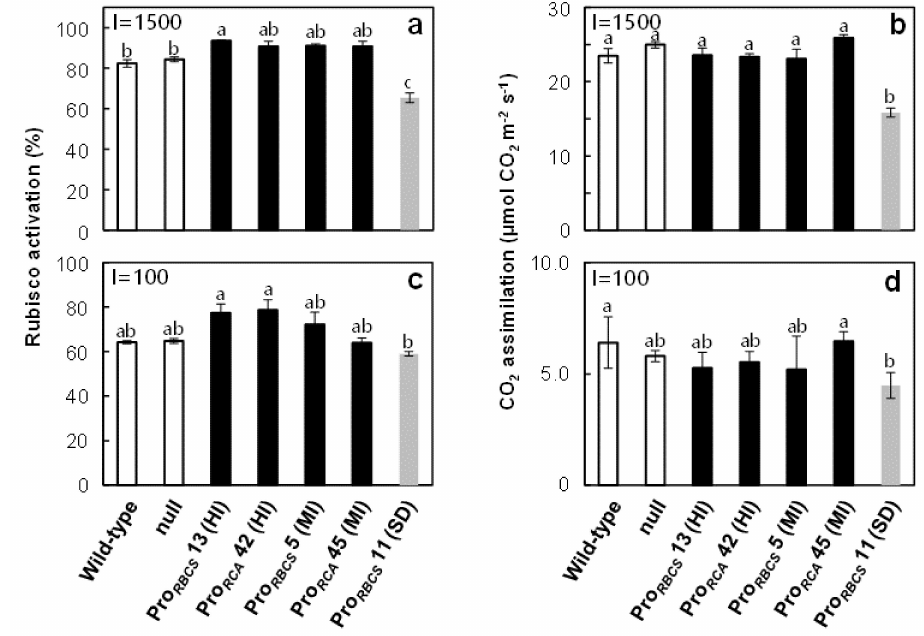
Figure 5. ( a,c ) Rubisco activation and ( b,d ) the rates of CO 2 assimilation at an ambient CO 2 partial pressure (Ca = 40 Pa) and high and low irradiances (PPFD of 1500 and 100 µ mol quanta m –2 s –1 ). Measurement were done on uppermost, fully expanded leaves in plants grown at 2.0 mM-N. The white, black, and grey bars indicate wild-type and null plants, RCA-overproduced plants, and plants with RCA suppression, respectively. Data are means ± SE ( n = 3–5). Statistical analysis was carried out by ANOVA with a post hoc Tukey–Kramer’s HSD test. Di ff erent letters indicate significant di ff erences among genotypes ( p <